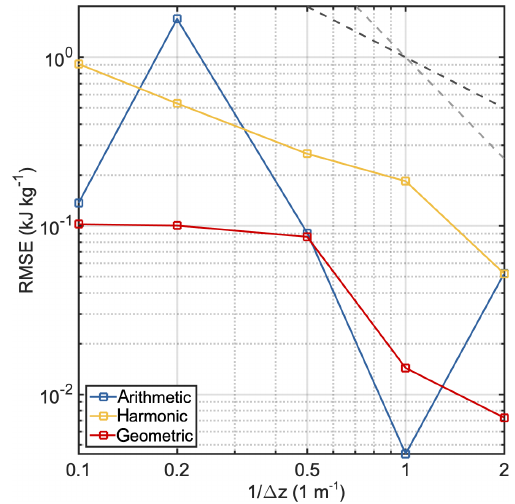
Figure 3. Root-mean-square error (RMSE) for the polythermal-slab experiment. The RMSE is computed between the modelled enthalpy result and the analytical solution for different vertical grid resolu- tions (cid:49)z and for each conductivity parameterization. Model results are obtained for the lowest conductivity ratio K 0 /K c = 10 − 5 . The dashed light and dark grey lines show the indicative rate for ((cid:49)z) 1 and ((cid:49)z) 2 ,